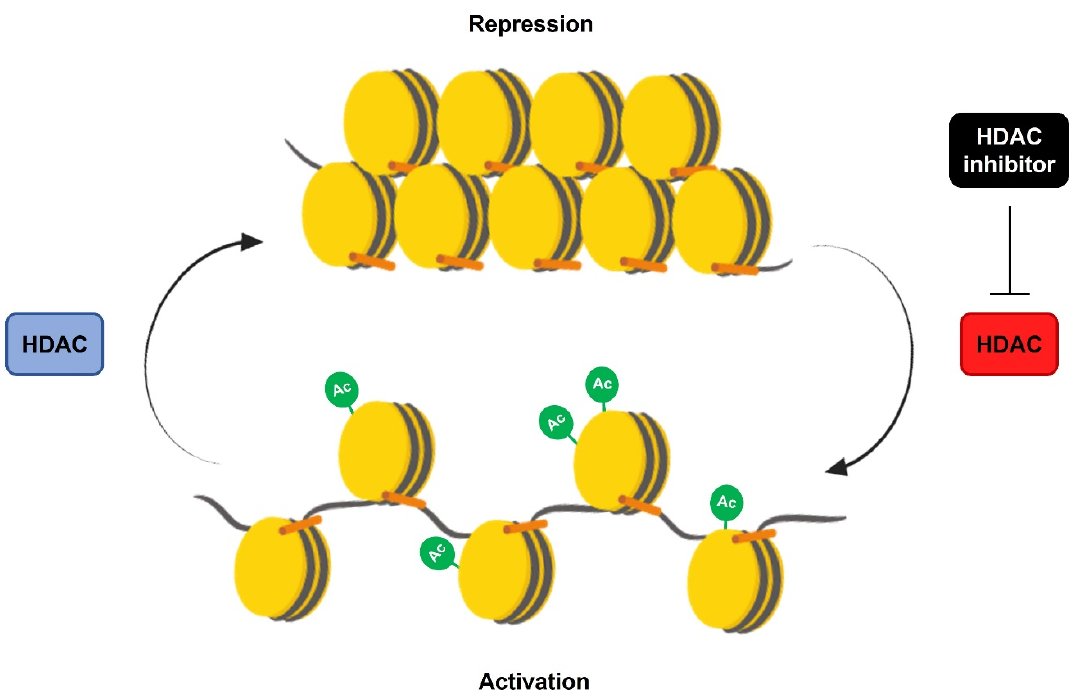
Figure 1 . The action of histone deacetylase inhibitors (HDACi) on histone acetylation and chromatin accessibility. HDACs promote the loss of histone acetylation by the removal of acetyl groups, which in turn causes a conformational change in the chromatin structure and, consequently, gene repression. In contrast, the use of HDACi prevents the action of HDACs, maintaining histone acetylation marks and activating gene expression.